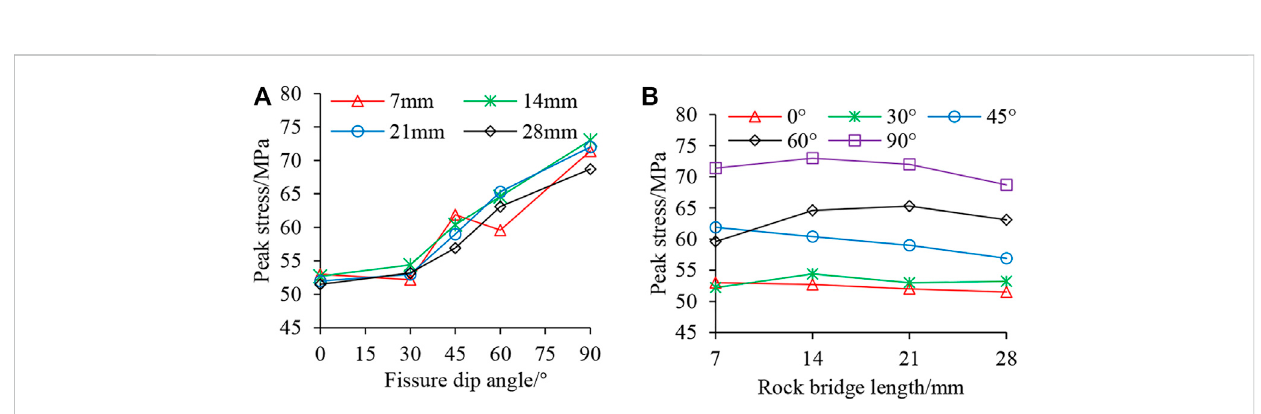
FIGURE 6 The variation of peak stress with fi ssured angles and rock bridge lengths. (A) Fissure dip angle VS. Peak stress; (B) Rock bridge length VS. Peak